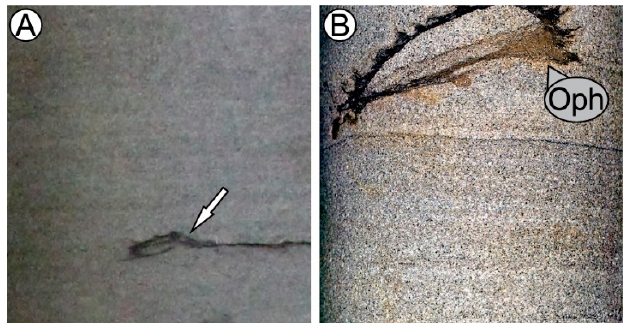
Figure 4. Representative misclassified images in EXP#1: ( A ) image showing a deformed mud-drape (white arrow). The deformation caused the mud-drape to resemble bioturbation labeled as BI 1–2 present in some of the other images in the training images. ( B ) Individual Ophiomorpha , which is misclassified owing to the lack of similar images in the training dataset.